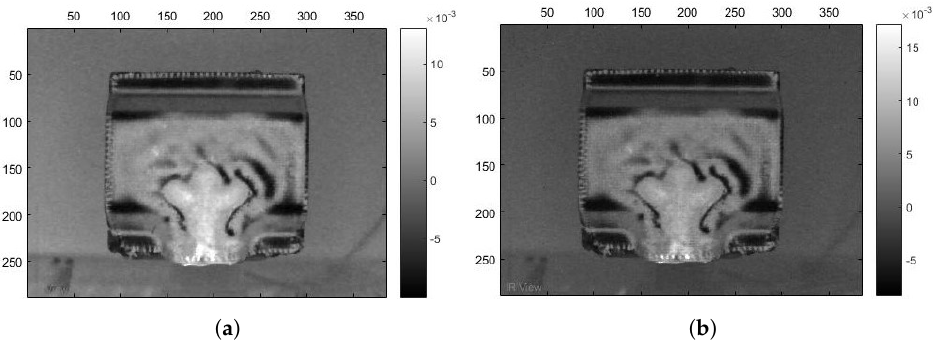
Figure 8. PCT results of sample without Teflon tape. ( a ) 2nd EOF of MWIR sequence, and ( b ) 2nd EOF of LWIR